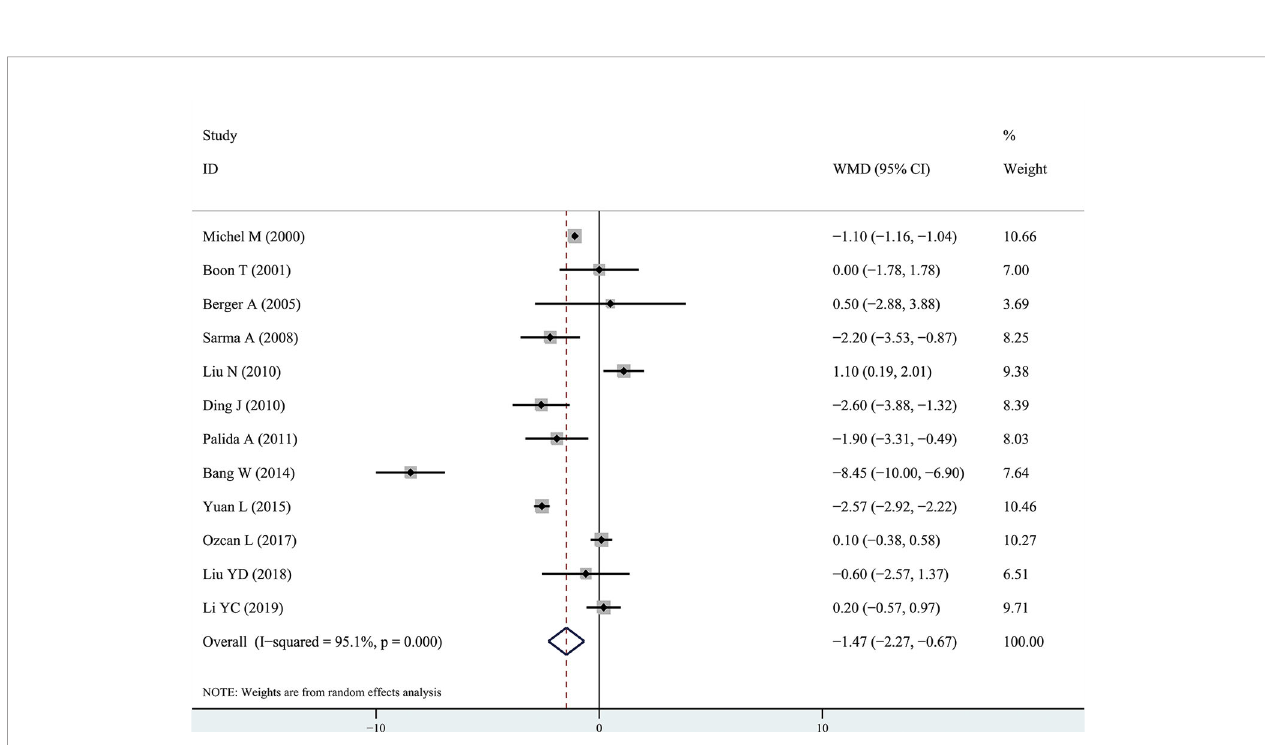
FIGURE 4 | Forest plots of maximal fl ow rate comparing diabetes group to without diabetes group in benign prostatic hyperplasia patients. The diamond represents the pooled Weighted Mean Difference (WMD) and 95% con fi dence intervals (CI).